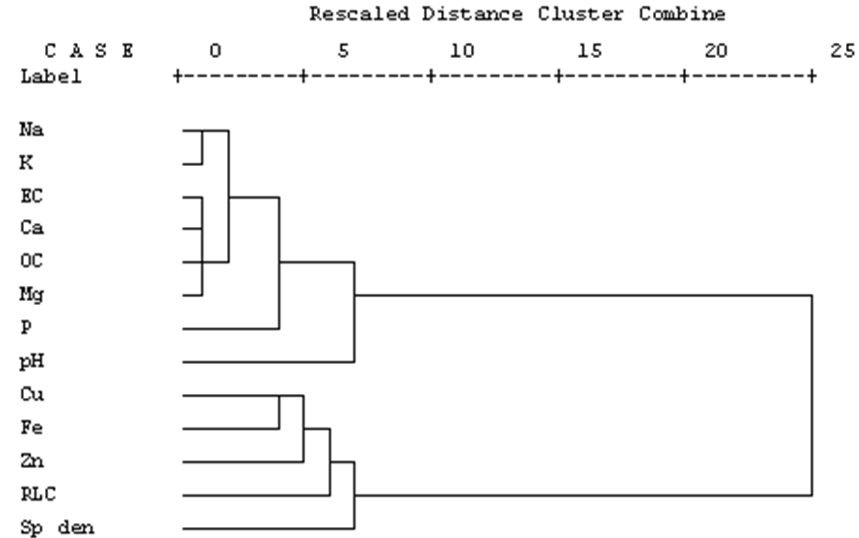
Fig. 4. Dendrogram obtained after agglomerative hierarchical cluster analysis among variables using Average Linkage. Note: OC-organic carbon, RLC-root length colonization, Sp den-spore